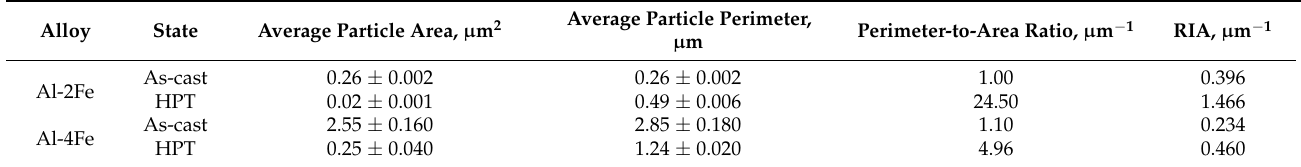
Table 2. Analysis data of Al-Fe alloys’ intermetallic particles, obtained from the SEM images. Alloy